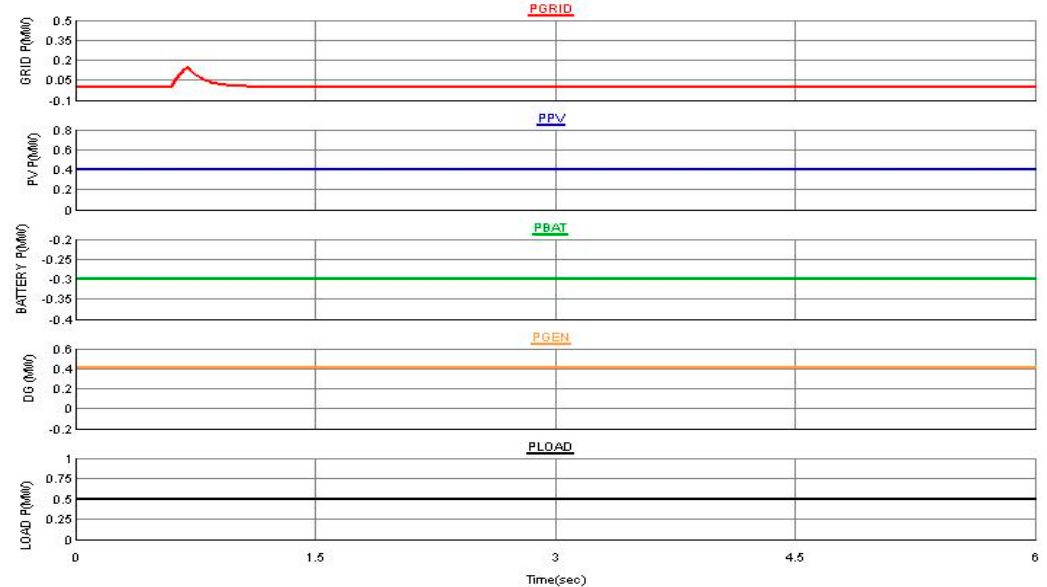
Figure 22. Grid power P GRID , PV array output power P PV , battery power P BAT , generator power P GEN and load power P LOAD during island